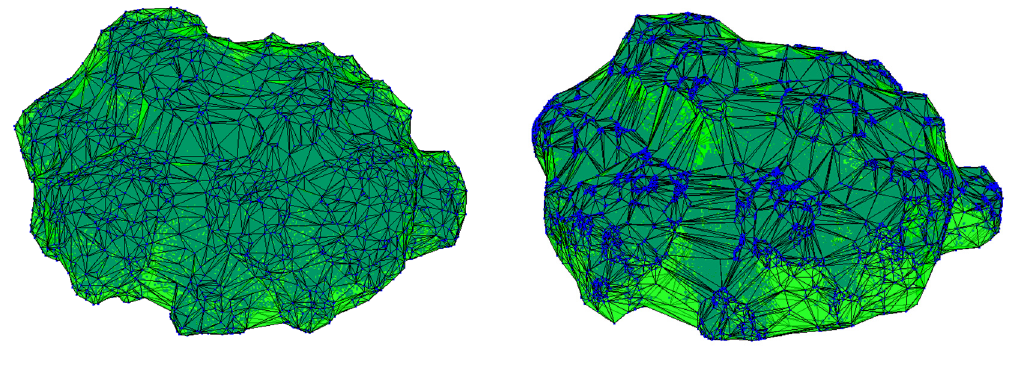
LiDAR Photogrammetry Figure 11. Comparison of different tree canopy parameters using LiDAR and photogrammetric point clouds, top: convex hull and bottom: concave hull.